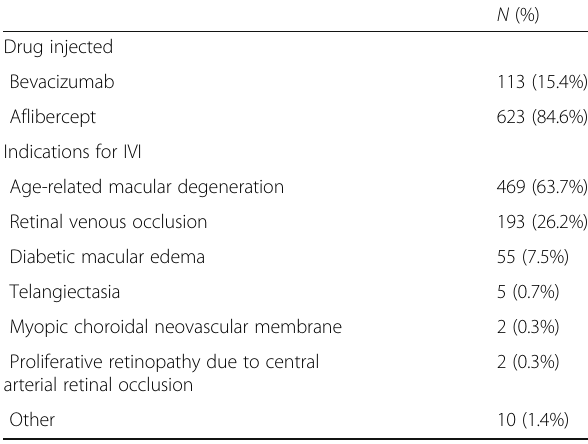
Table 1 Sample characterization of 736 intravitreal injections